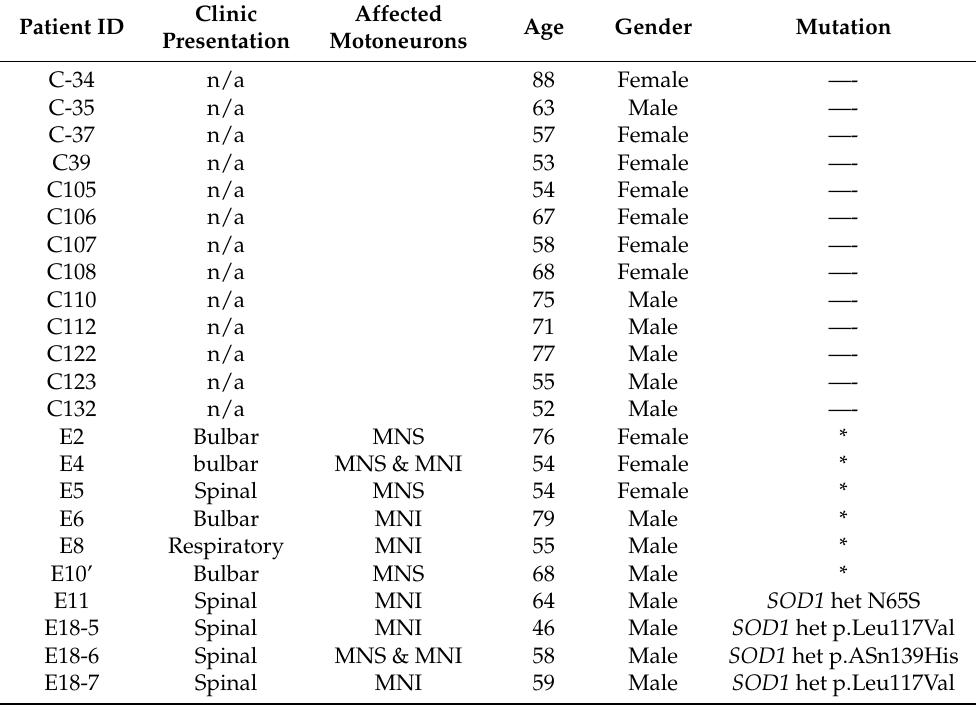
Table 1. Demographic and clinical characteristics of the subjects. * Negative for SOD-1 , TARDBP , and